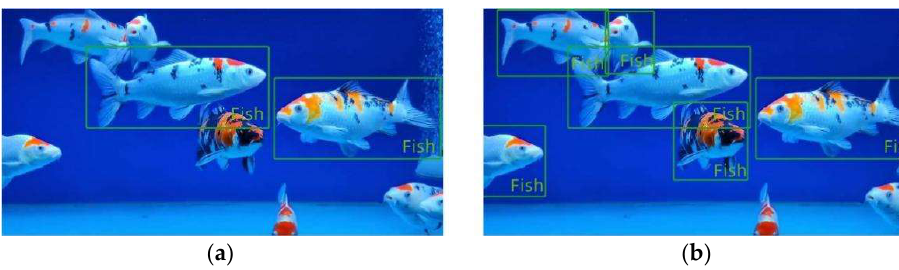
Figure 8. Performance of individual fish detection with CBAM: ( a ) is the performance of normal detection method; ( b ) is the performance of detection method with CBAM.